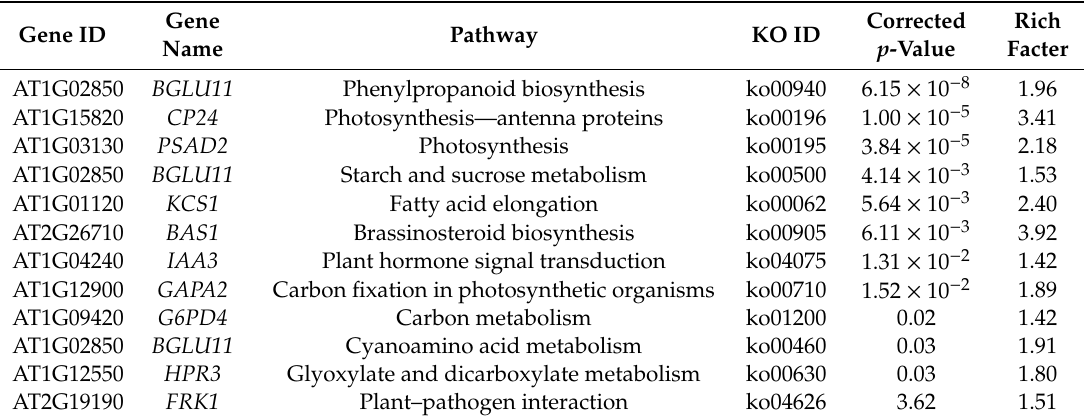
Table 1. Significant representative di ff erentially expressed genes (DEGs) involved in KEGG enrichment during the transitional stage (DCIM7 vs. DSIM7, RCIM7 vs. RSIM7).